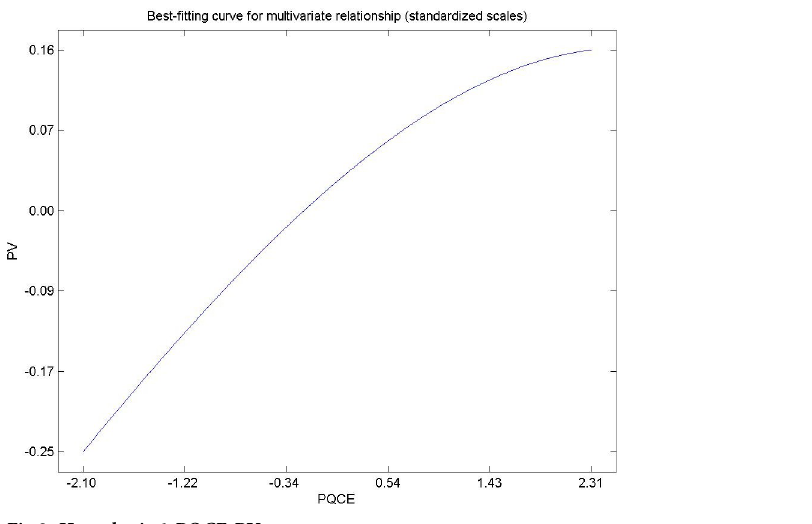
Fig 8. Hypothesis 6, PQCE-PV.